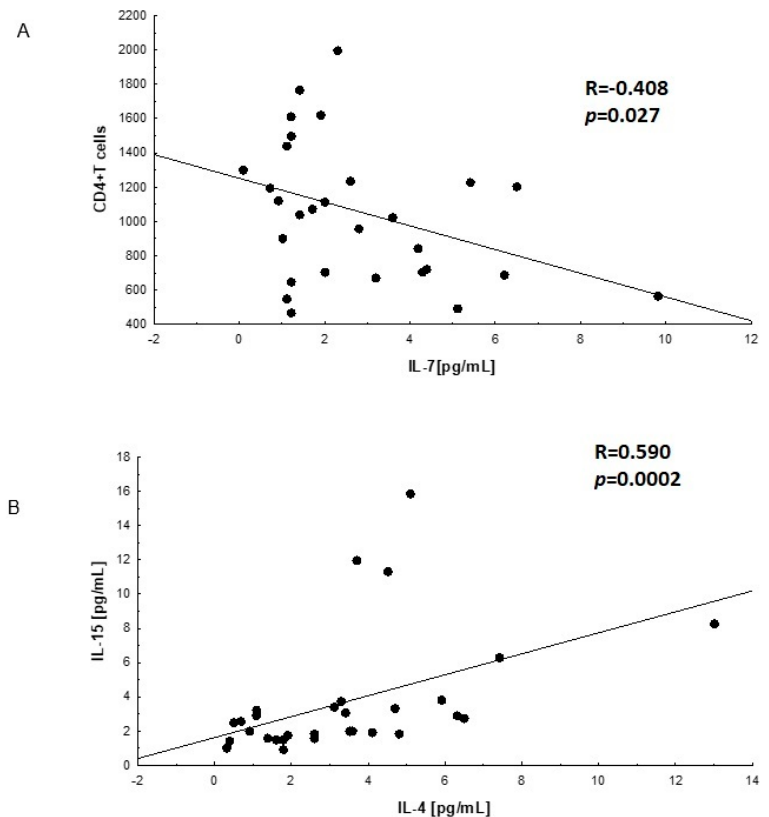
Figure 1. Correlations between interleukins. ( A )—linear relationship between IL-7 concentration and the number of lymphocytes T CD4 + in plasma of HIV-infected men before cART; ( B )—linear relationship between IL-4 and IL-15 in plasma of HIV-infected men after cART; the correlations were evaluated with Spearman’s non-parametric test.